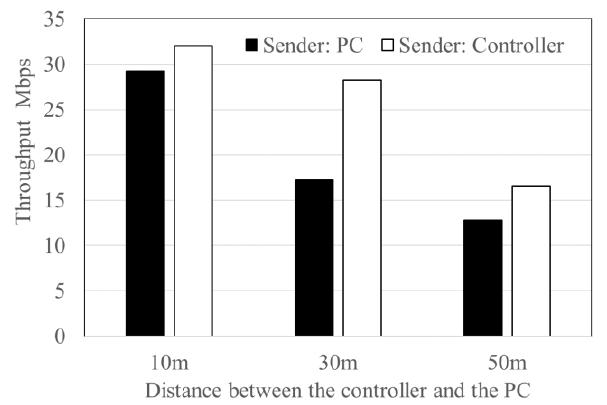
Figure 8. Average TCP throughput in each communication distance: The black bar is the results when the PC is the sender, and the white bar is results when the communication controller is the sender, respectively.